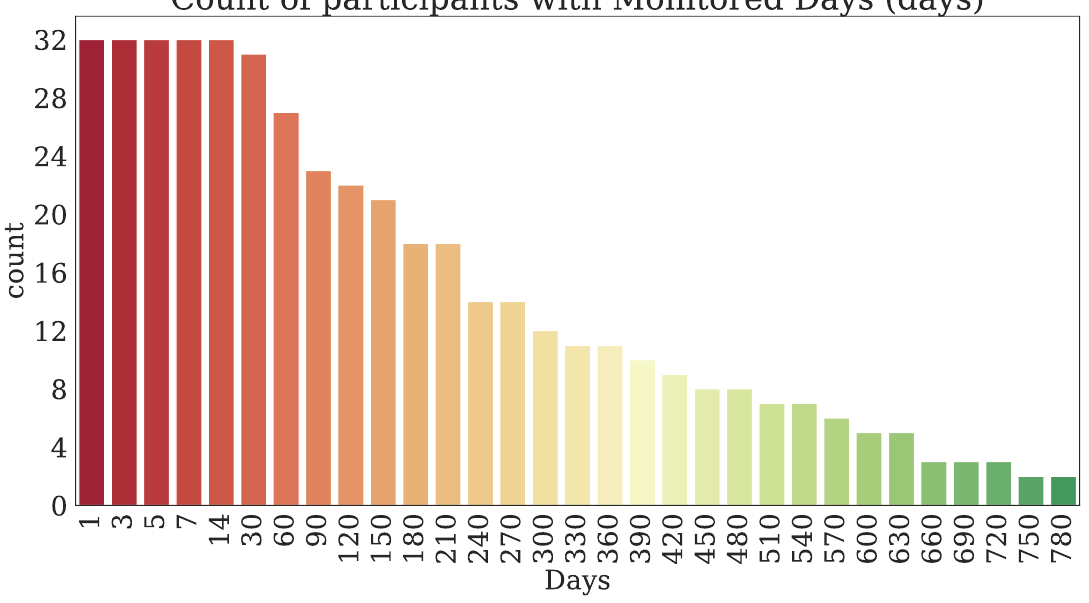
Figure 4. Count of seniors with at least the given monitored days of Fitbit (TechRO).